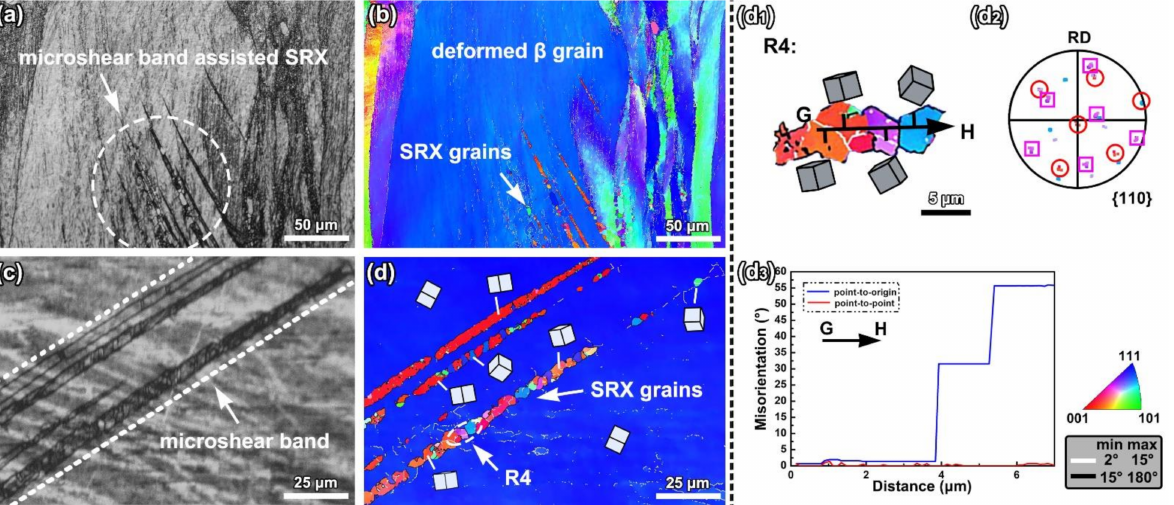
Figure 6. Analysis of static recrystallization mechanism in the micro-shear band of specimen HT-1: ( a , c ) band contrast (BC) maps; ( b , d ) IPF maps; ( d 1 ) IPF map of the local region 1 within the micro- shear band; ( d 2 ) corresponding PF map of the region 1; ( d 3 ) the misorientation angle along with black arrow AB and corresponding pole